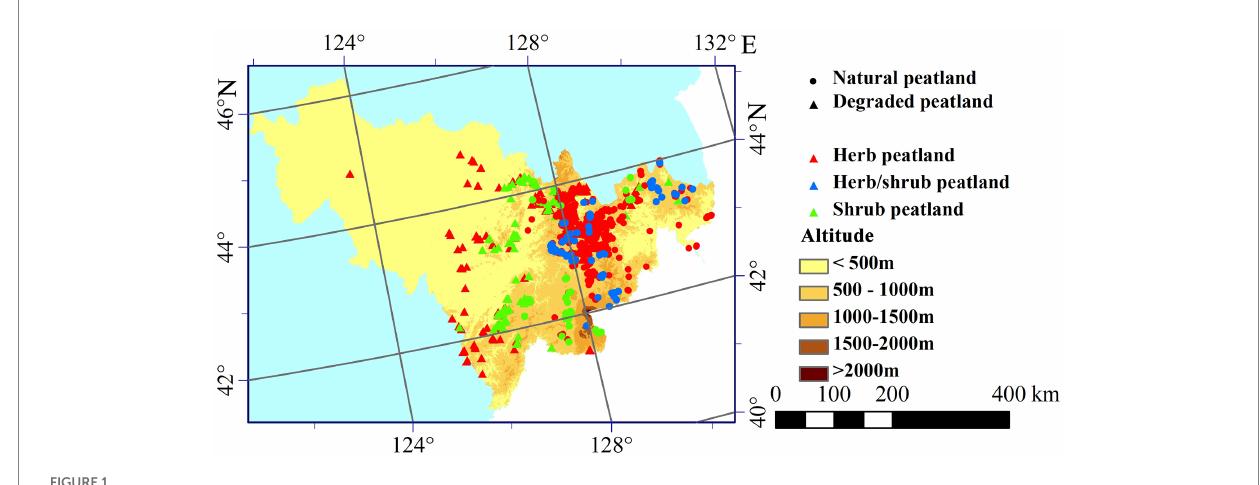
FIGURE 1 Locations of peatland sampling in Jilin Province,